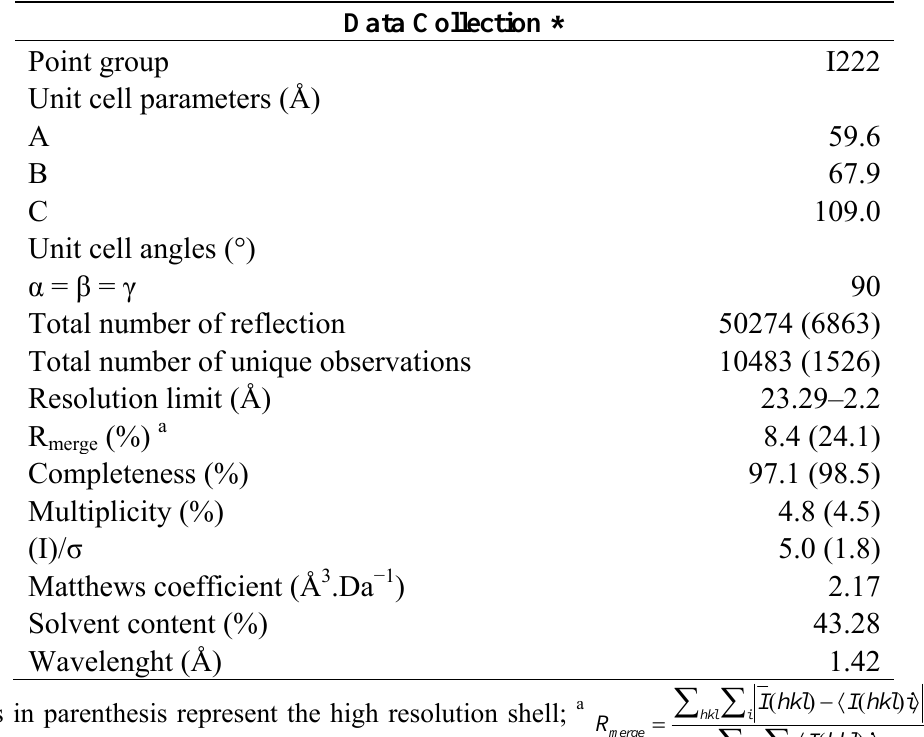
Table 3. Refinement statistics for crystal structure data collection of the lectin from the seeds of Dioclea wilsonii